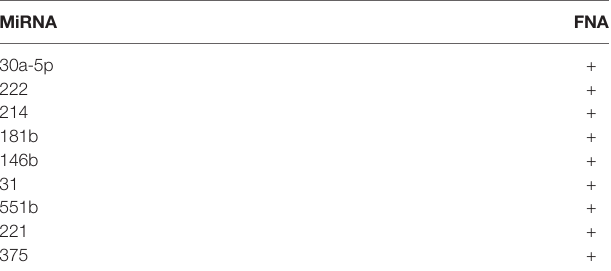
TABLE 3 | MiRNAs detected in FNA